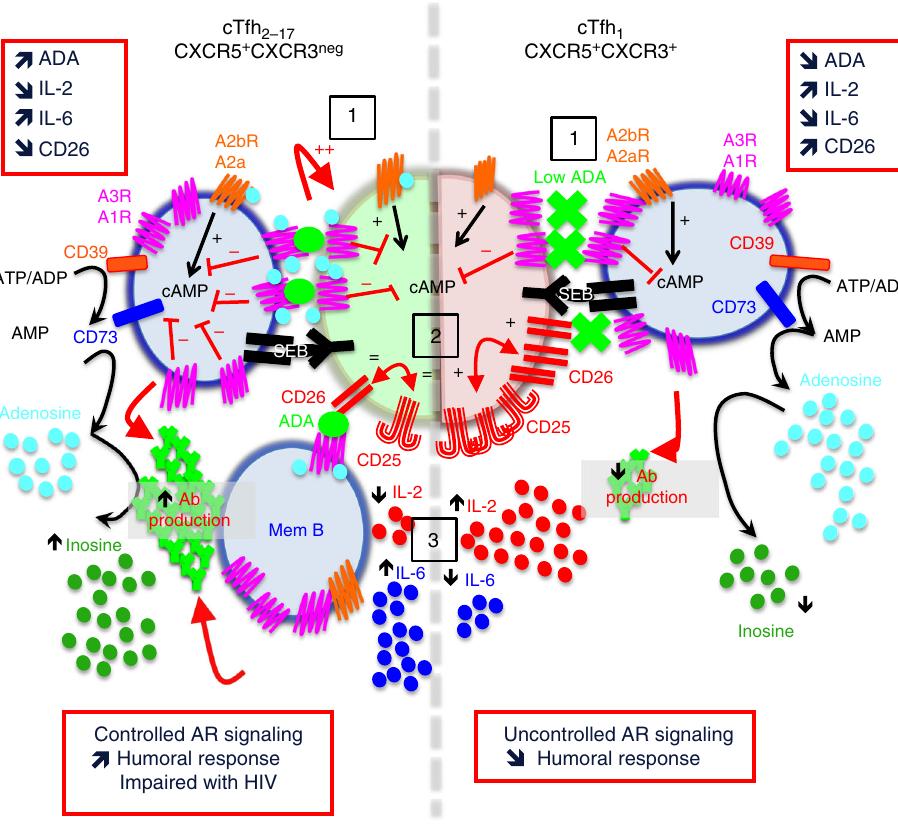
Fig. 8 ADA-1 delineates human cTfh subset function – In cTfh 2-17 subset, ADA-1 by binding to A1R (which is mainly expressed by T/B cells), behaves as an allosteric effector that markedly enhances adenosine af fi nity for A1R and increases receptor functionality (1) (leading to controlled CD26/IL-2/ IL-6 signaling (2 – 3)), in addition of reducing adenosine concentration and therefore metabolite accessibility for other ARs. Inversely, cTfh 1 subset does not up-regulate ADA-1 expression, which leads to less ef fi cient memory B cells interaction, more CD26/CD25 cross-talk (2), more IL-2 expression and less IL-6 signaling